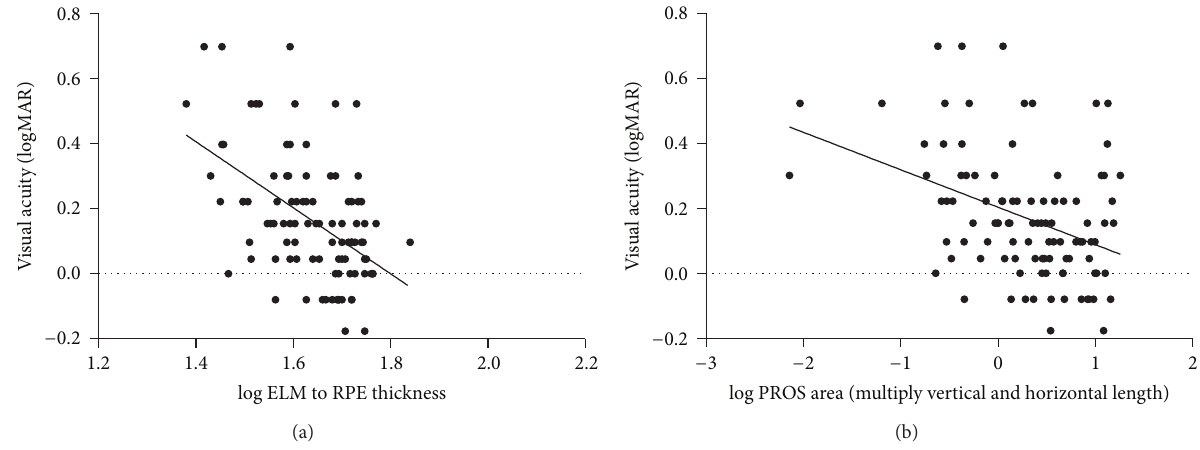
Figure 4: Scatter plot showing the relationships between the log outer retinal thickness (ELM to RPE) and logMAR visual acuity (a) and log PROS area (multiple vertical and horizontal lengths) (b). Solid line: the prediction of a linear